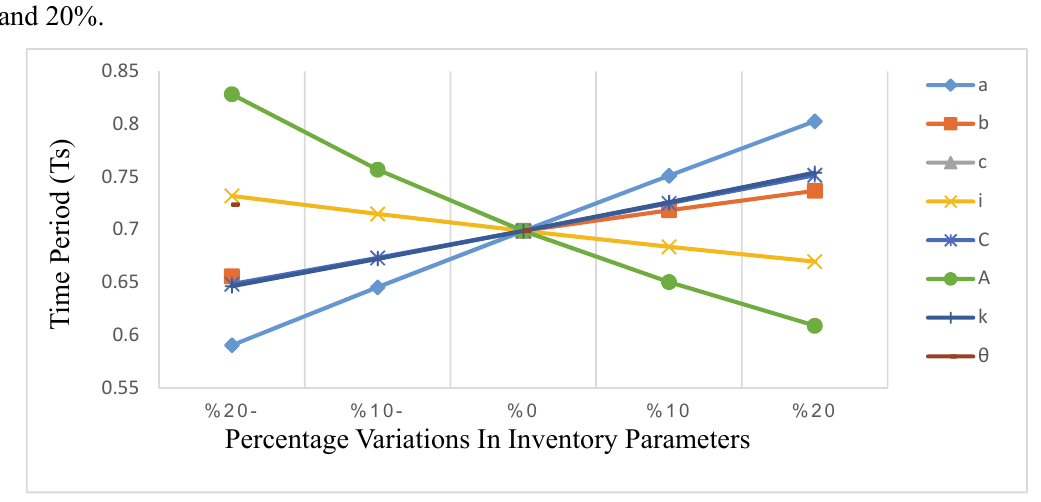
Fig. 5 Variations in time period